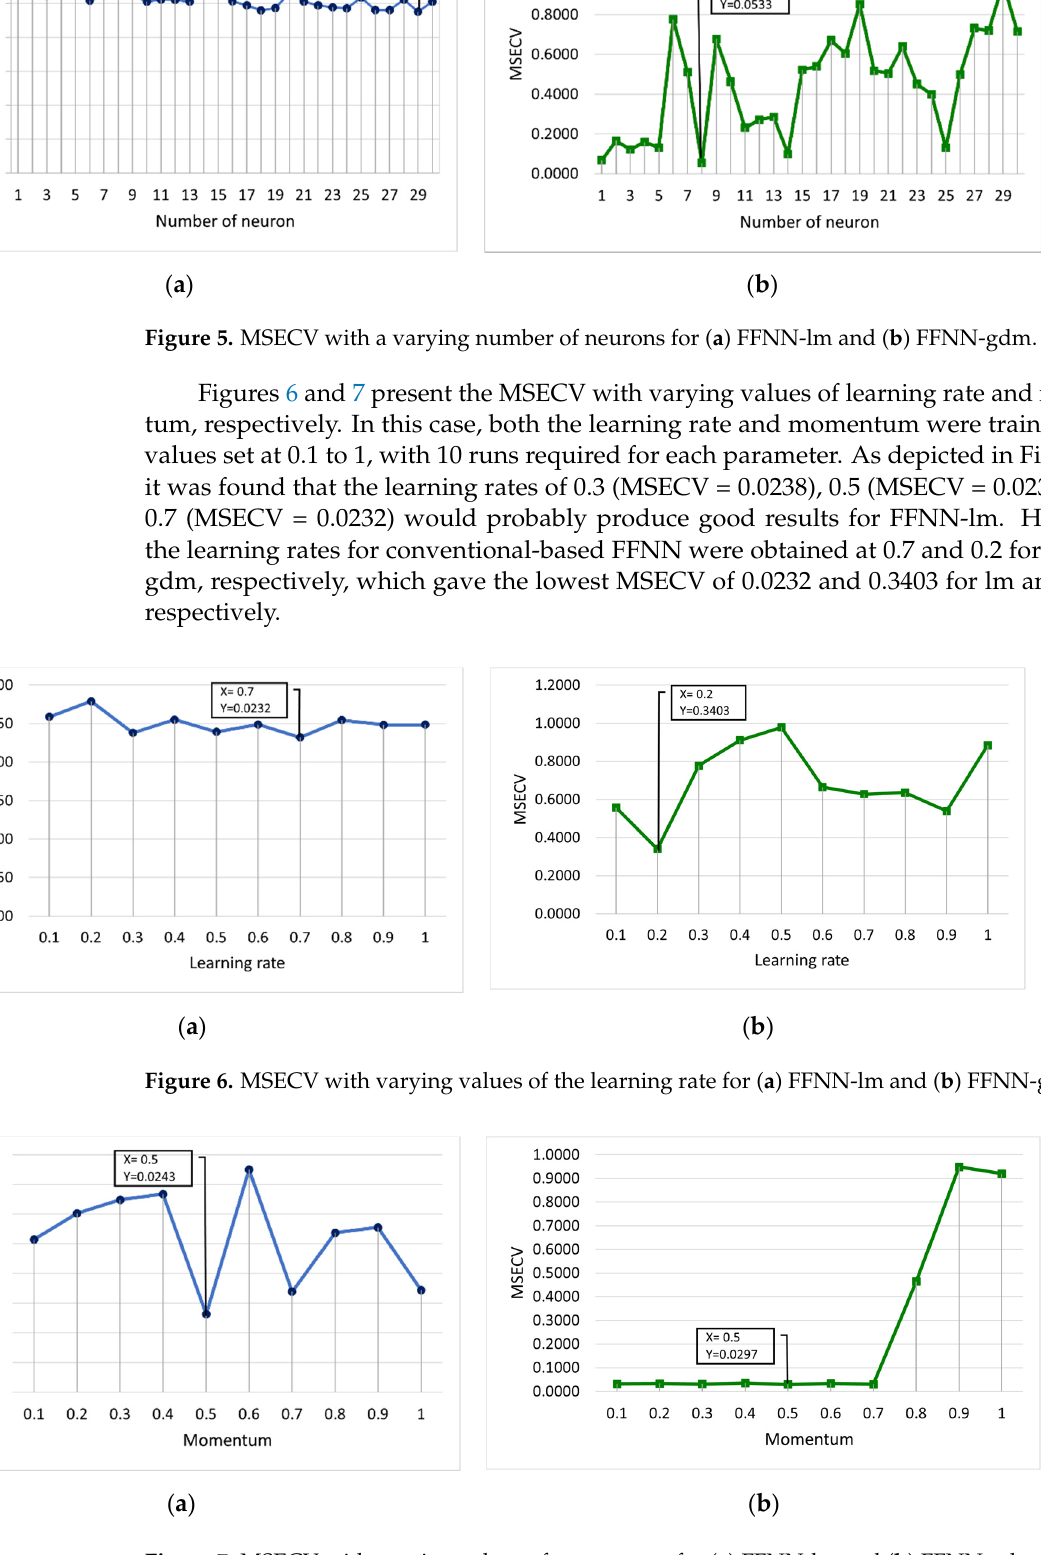
Figure 7. MSECV with varying values of momentum for ( a ) FFNN-lm and ( b ) FFNN-gdm.